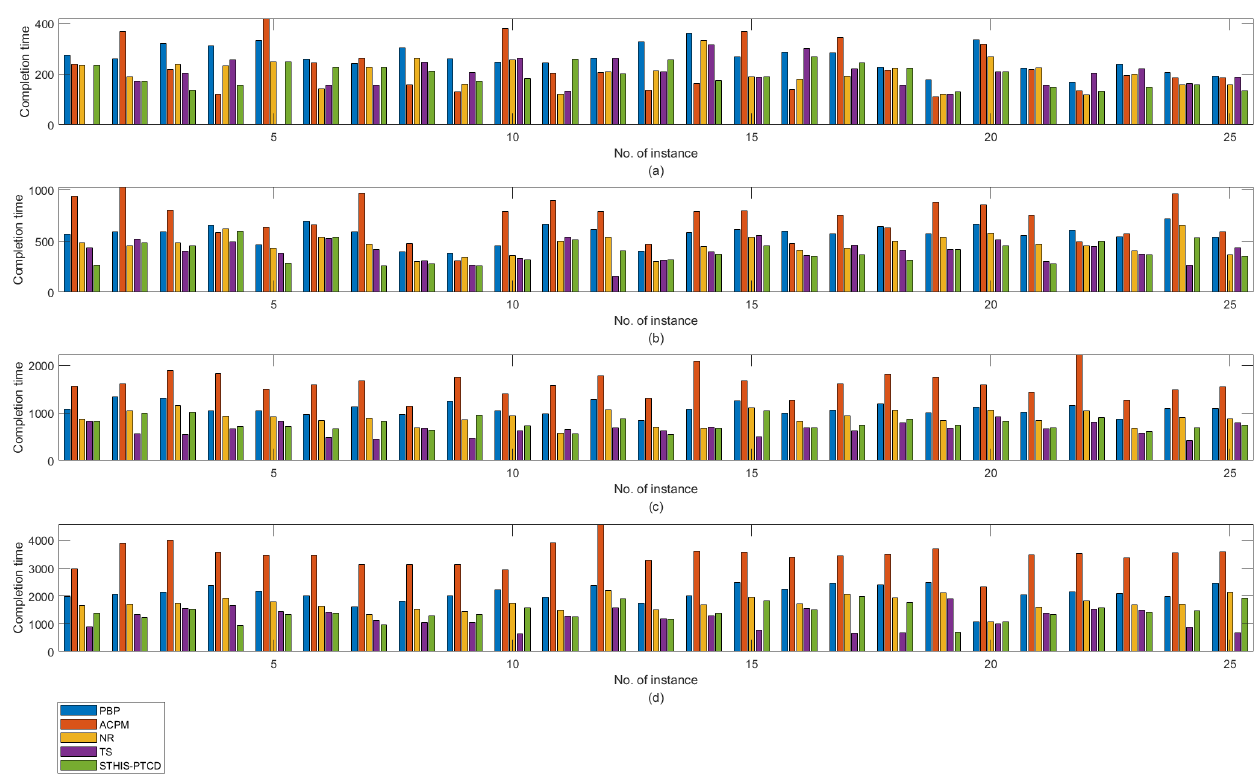
Figure 26. Results of the PBP, ACPM, NR, TS, and STHIS-PTCD for integrated scheduling in the workshop with the shortest completion time: ( a ) 20 operations; ( b ) 50 operations; ( c ) 100 operations; ( d ) 200